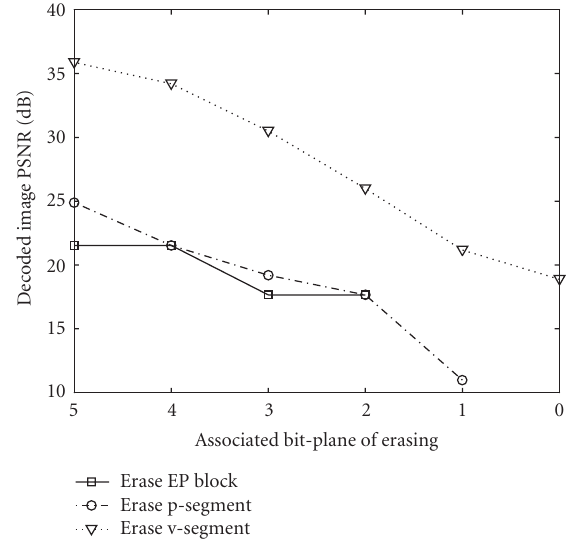
Figure 6: Image quality for “building” with erasing di ff erent p- segments, v-segments, or EP blocks in di ff erent bit-planes.